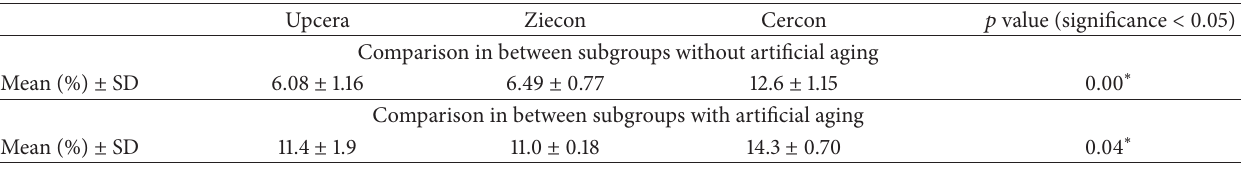
Table 7: The comparison between the mean of phase transformation (m-phase fraction) Vol% values and their respective standard deviation of all the three groups, that is, Upcera, Ziecon, and Cercon, within each subgroup. Upcera